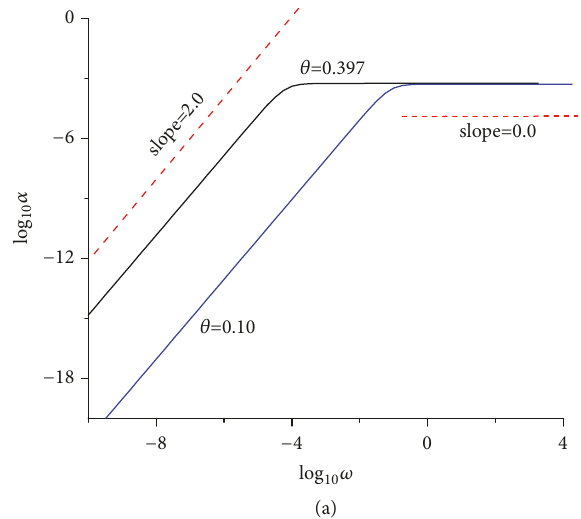
Figure 1: Sound dispersion at different frequencies of sound for 𝐿 = 0.02 , 𝑝 = 0.98 , and 𝑑 = 𝑑 = 0.45 . The number accompanying each 𝐶 Figure 2: Double logarithmic plot of attenuation versus frequency curve represents the value of the sound frequency 𝜔 . for 𝐿 = 0.02 , 𝑝 = 0.98 , 𝑑 = 𝑑 𝐶 = 0.45 , and 𝜃 𝐶 = 0.39747 . The number accompanying each curve represents the value of the reduced